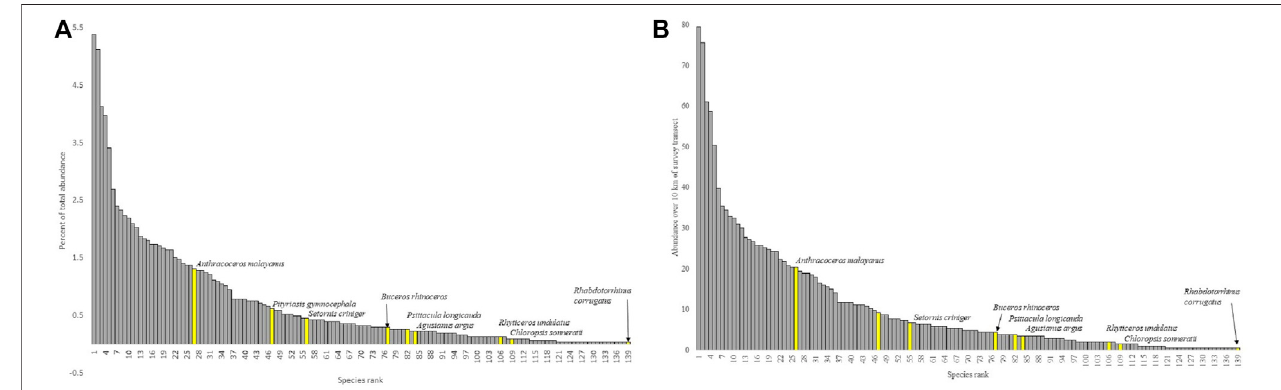
FIGURE7 | Rank abundance (A) percentage of total abundance byspecies rank (from most abundant toleast) and (B) as average number ofindividualsper 1 km of survey transect. Yellow highlighted bars represent the eight species listed as Vulnerable or more threatened by the IUCN that were detected on during point counts.